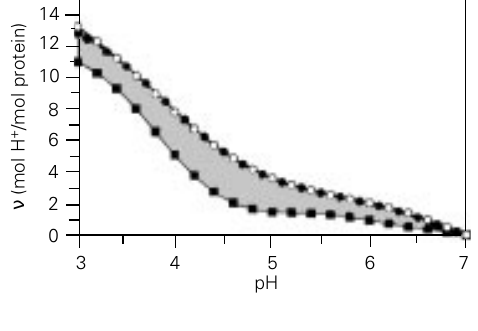
Figure 2 - ß-Trypsin titration curves of n moles of hydrogen ion bound per mole of protein as a function of pH. The area under the curves delimited by filled squares and open circles corre- sponds to the titration free en- ergy changes of folded ß-trypsin ( D G 0 N ), and unfolded ß-trypsin ( D G 0 U ), respectively. The shaded area corresponds to the change of noncovalent free energy as- sociated with the native to dena- tured conformational transition of ß-trypsin expressed as DD G 0 U-N = 9.51 ± 0.06 kcal/mol. The superposed curve (filled circles) corresponds to the theo- retical curve for the unfolded